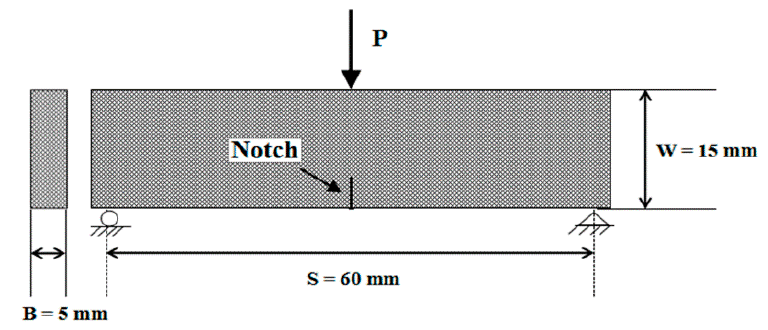
Figure 3. Single edge notched beam (SENB) specimen configuration for fracture experiments.